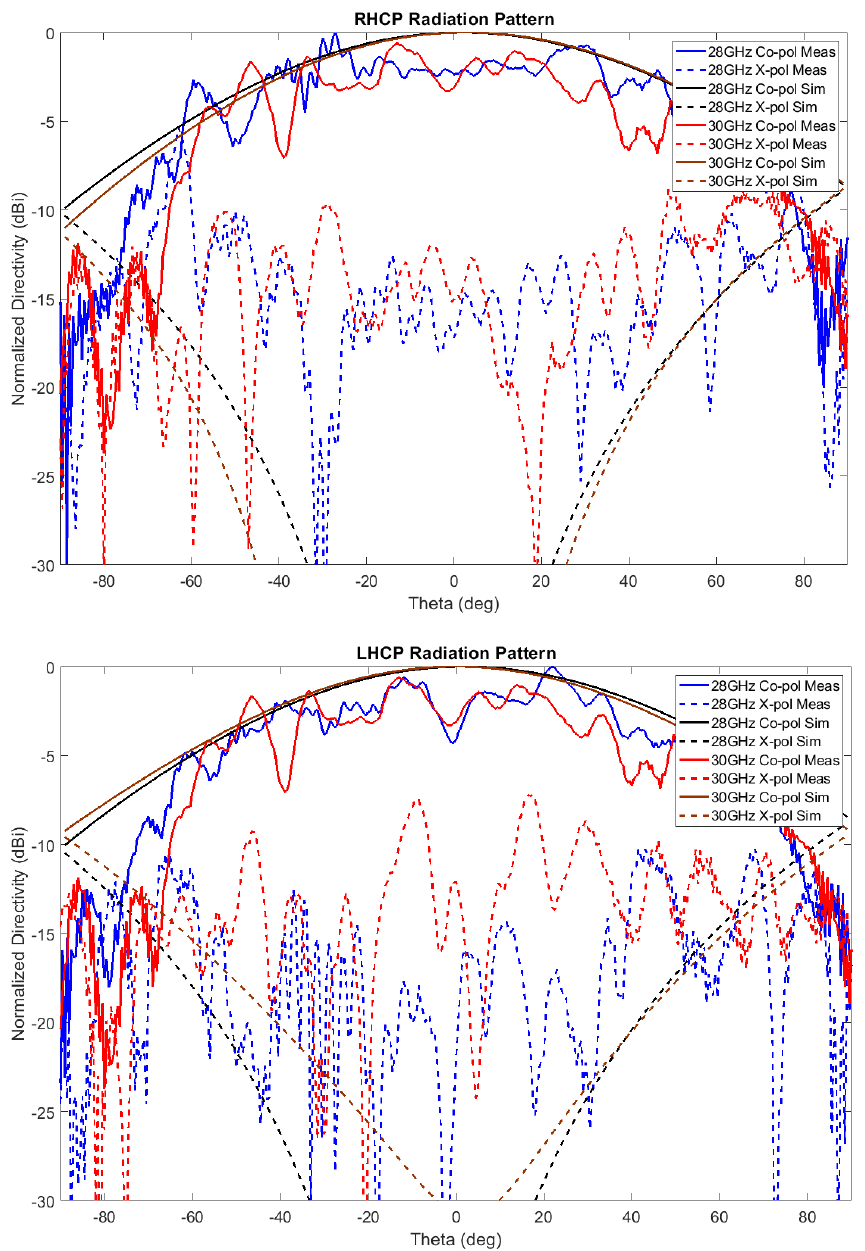
Figure 7. Antenna element normalized radiation patterns at φ = 0° for RHCP ( above ) and LHCP ( below